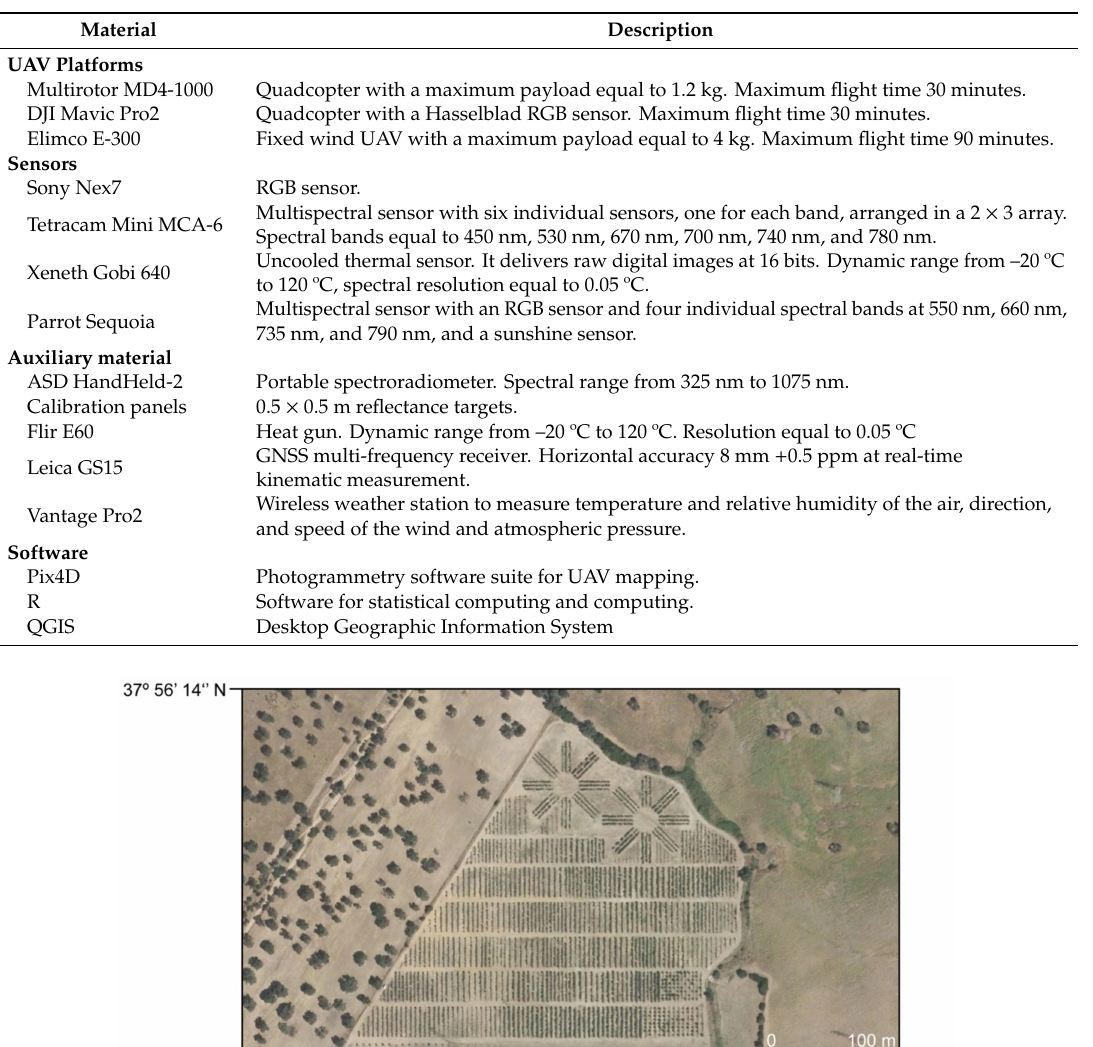
Table 2. Technical characteristics of the UAV platforms, sensors, auxiliary materials, and software used by students.